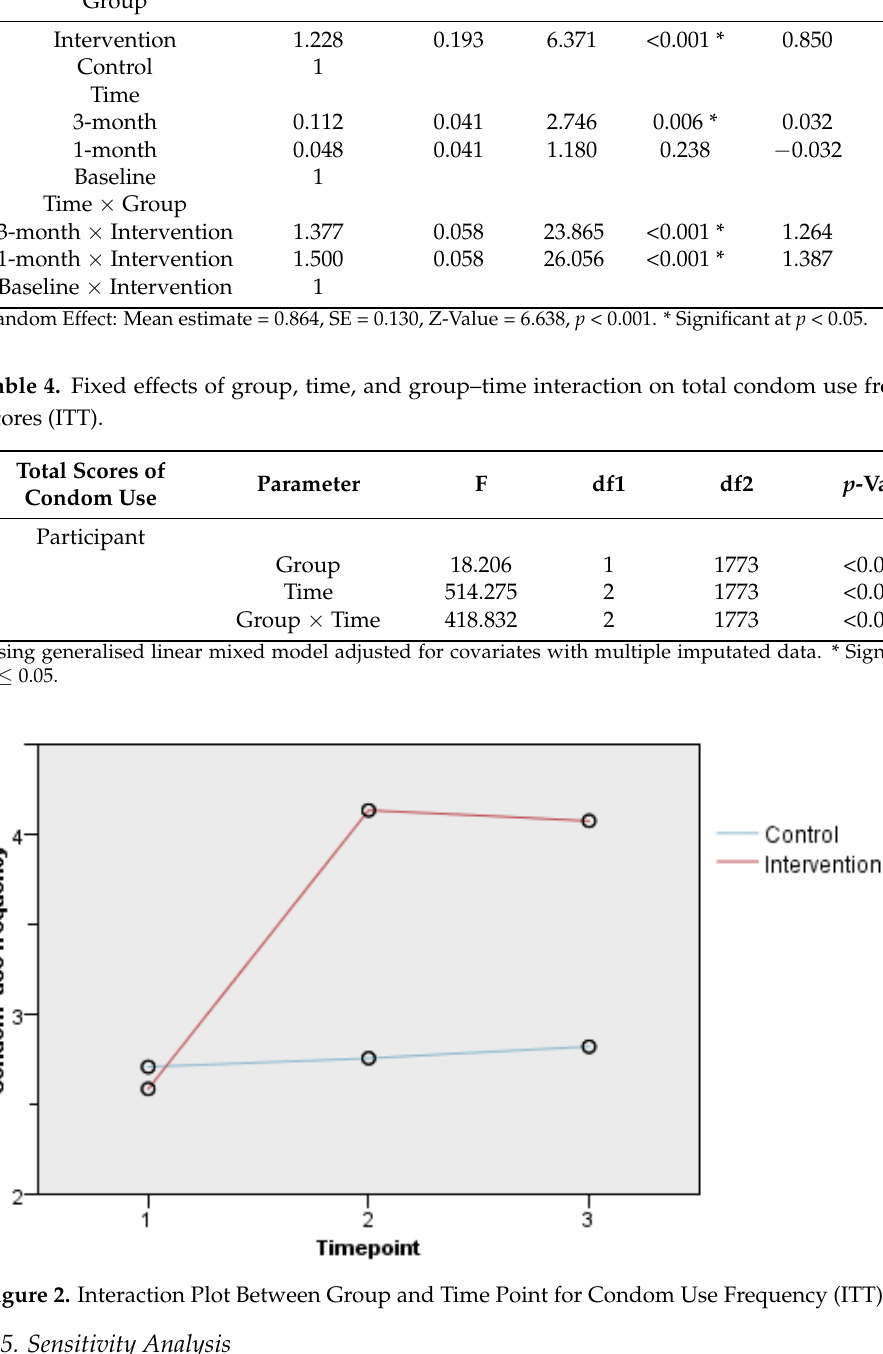
Figure 2. Interaction Plot Between Group and Time Point for Condom Use Frequency